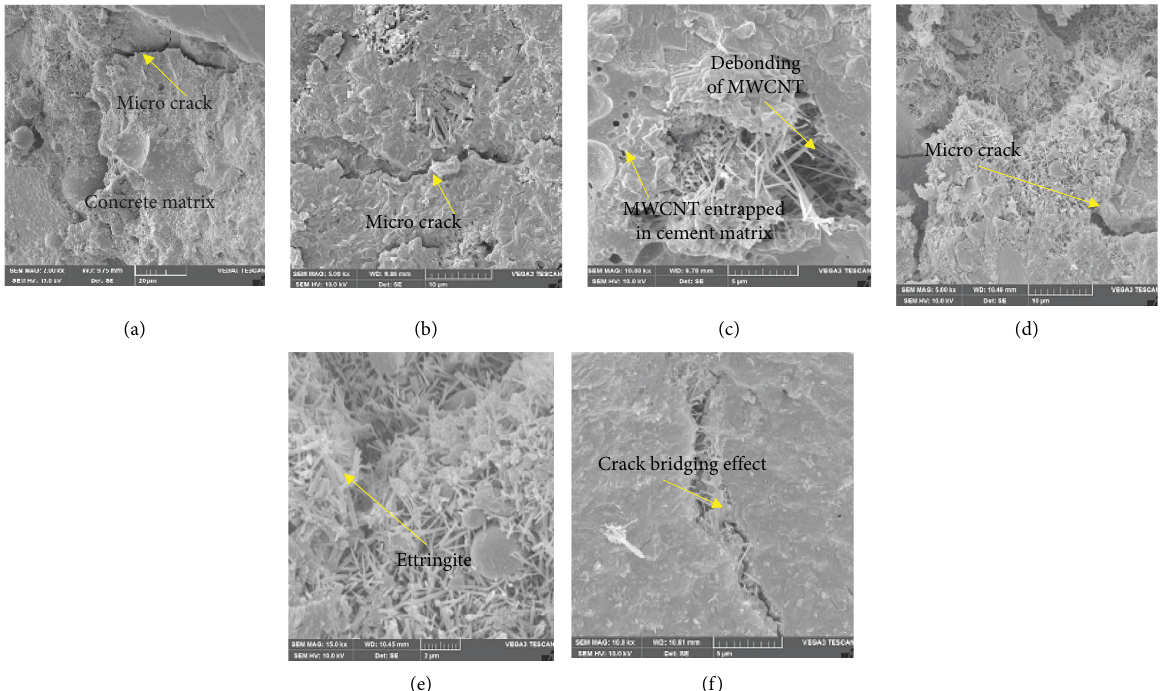
Figure 18: (a) SEM images of control. (b) MWCNT without steel fbres. (c–f) MWCNT with steel